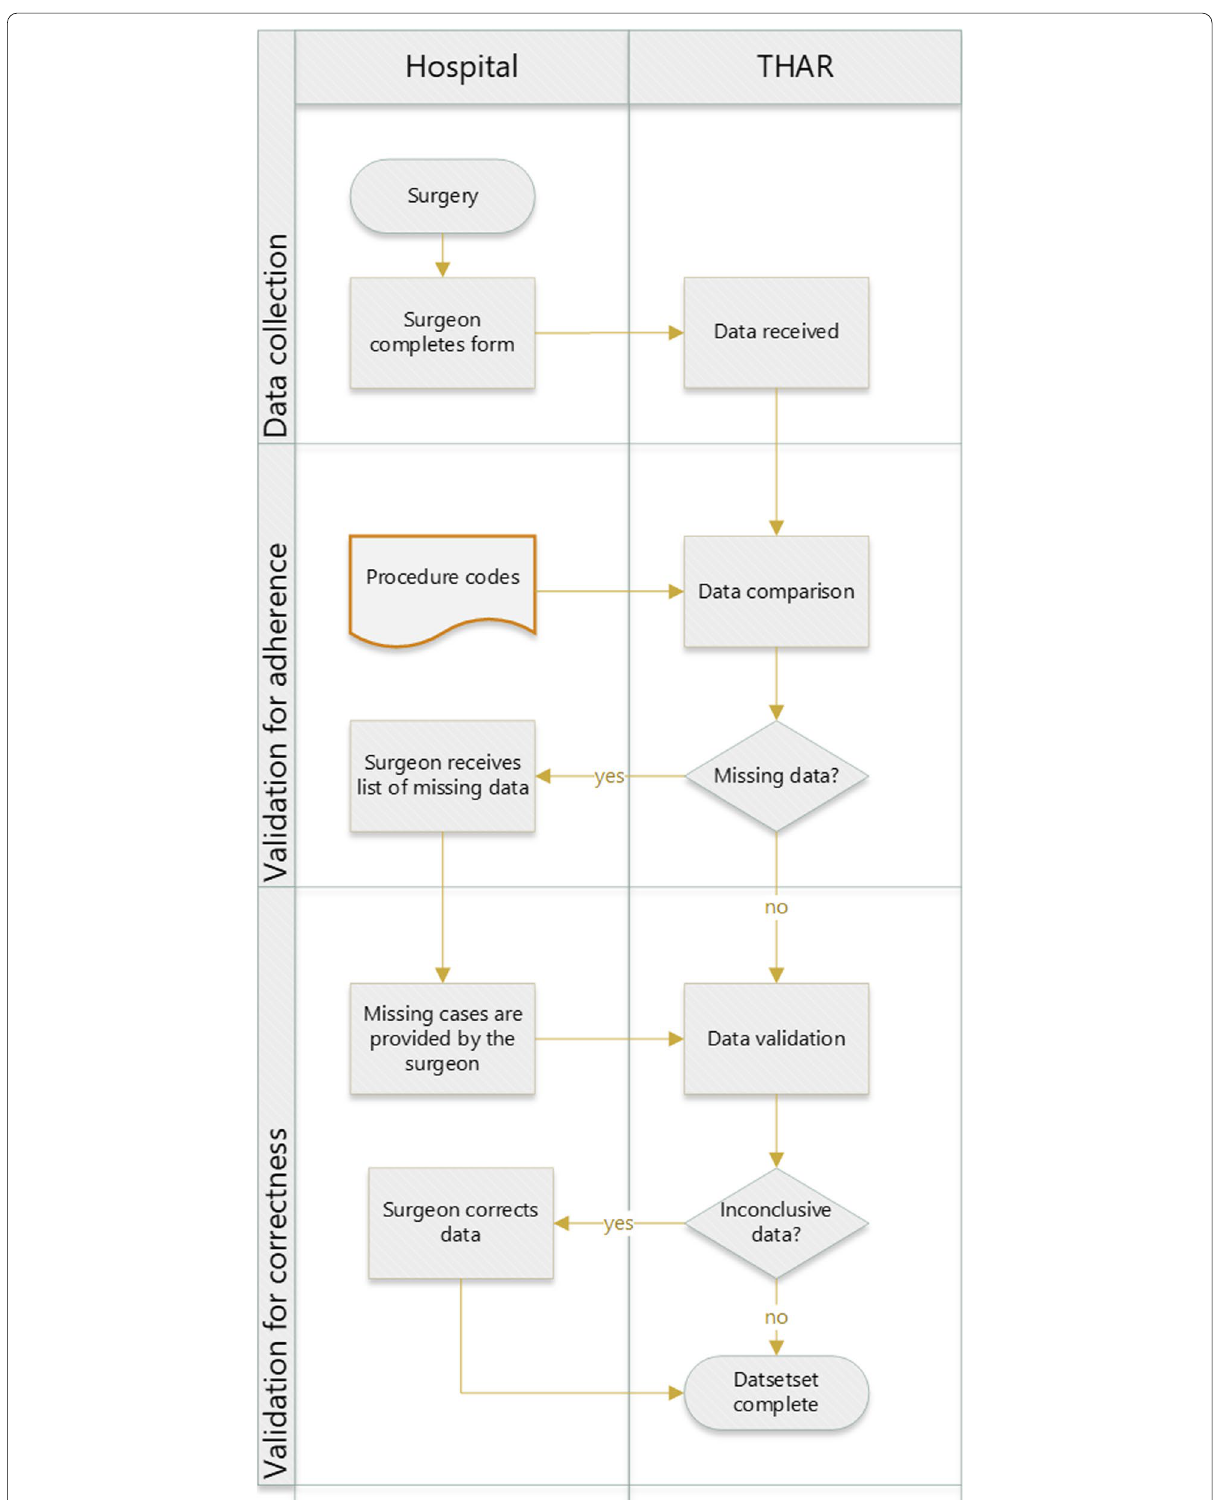
Fig. 1 Flowchart of the internal validation process for data from the THAR. THA: Total hip